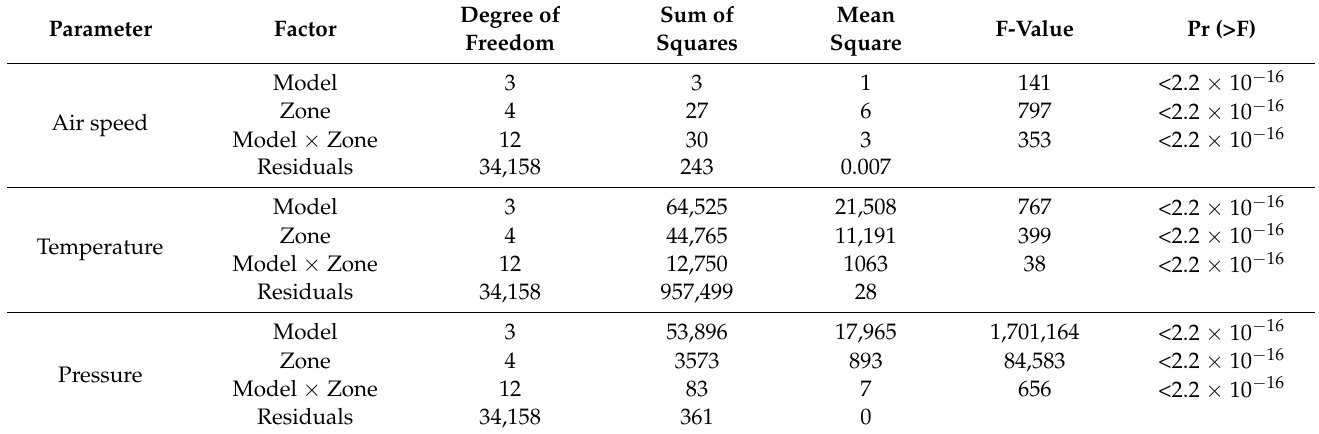
Table 4. ANOVA of environmental data from five animal-zones at Plane F.